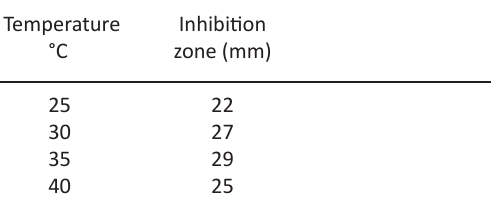
Table 6. Effect of the incubation temperature of Streptomyces MK388207 (M12) on the production of antimicrobial agents against Candida albicans ATCC